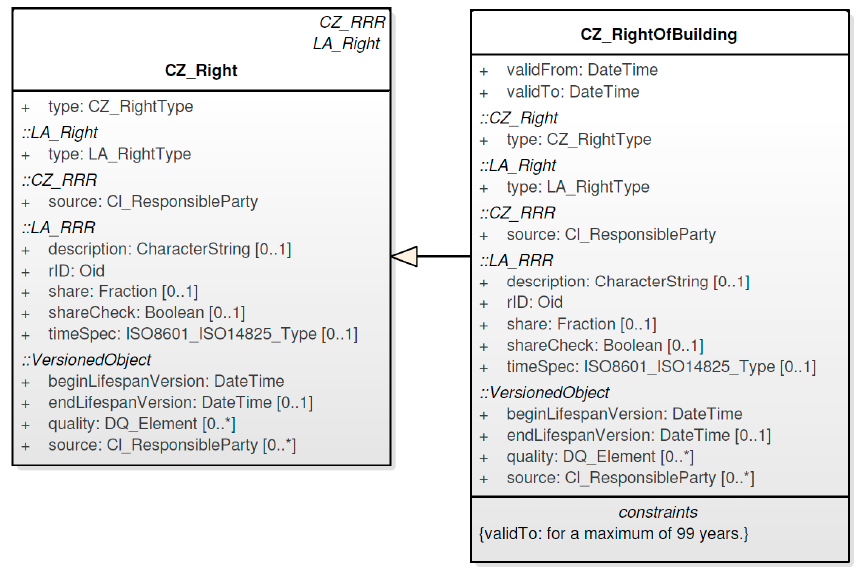
Figure 4. Right of building. The right of building can be established for a maximum of 99 years.